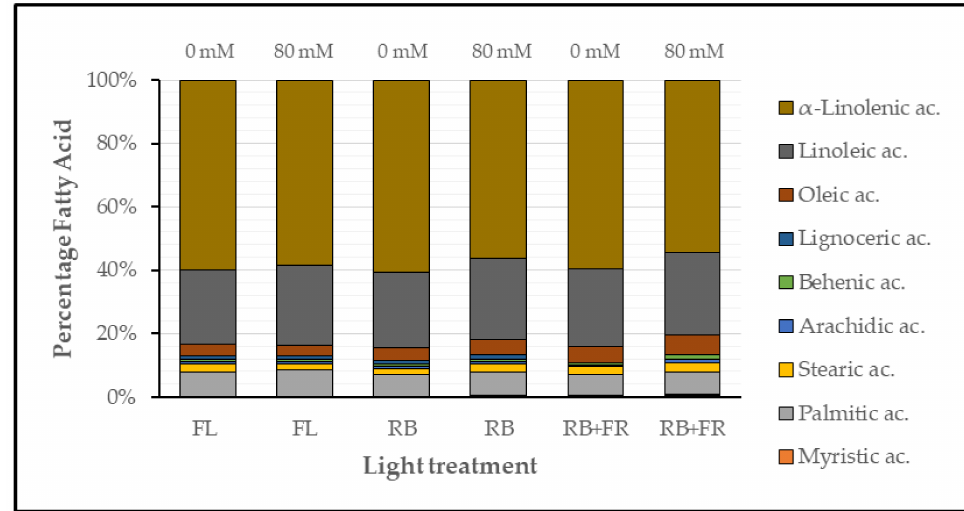
Figure 5. Percentage of fatty acid content of the aerial part of purslane microgreens for the different light treatment (FL, RB and RB+FR) and salinity (0 and 80 mM NaCl)